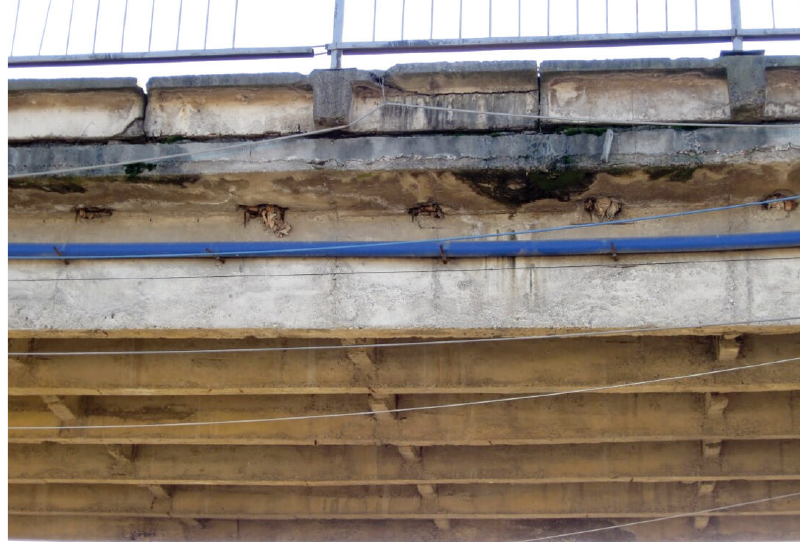
Figure 19. Parapet defect on reinforced concrete